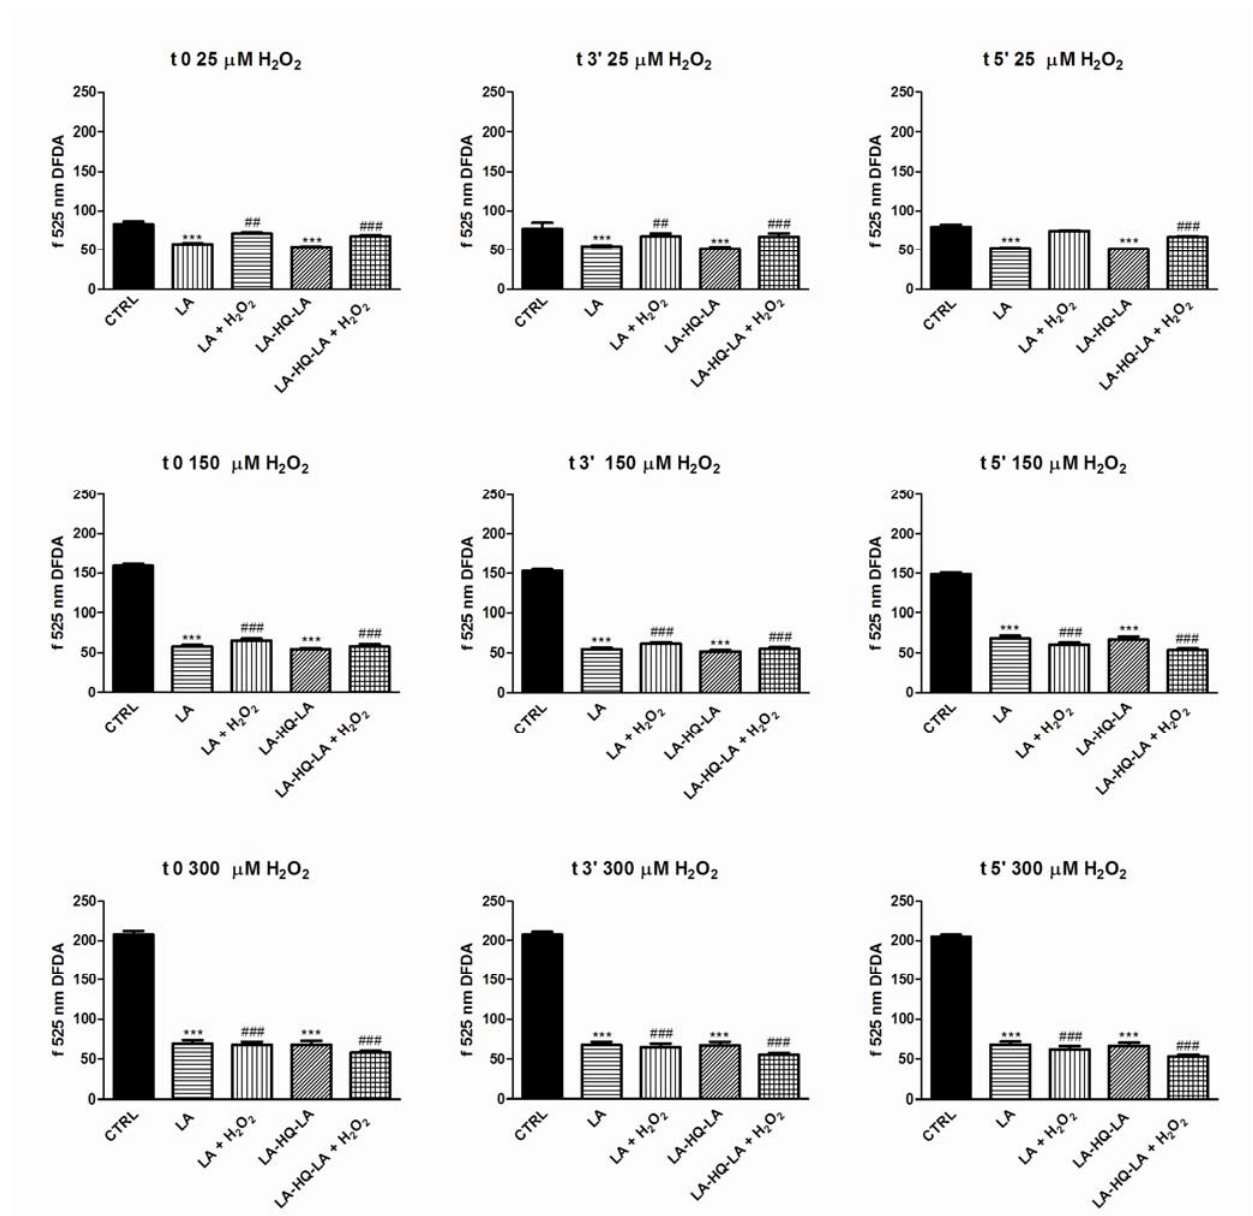
Figure 6. Antioxidant capabilities of LA and LA-HQ-LA in RA-differentiated and H O -lesioned SH-SY5Y human neuroblastoma cells a 2 2